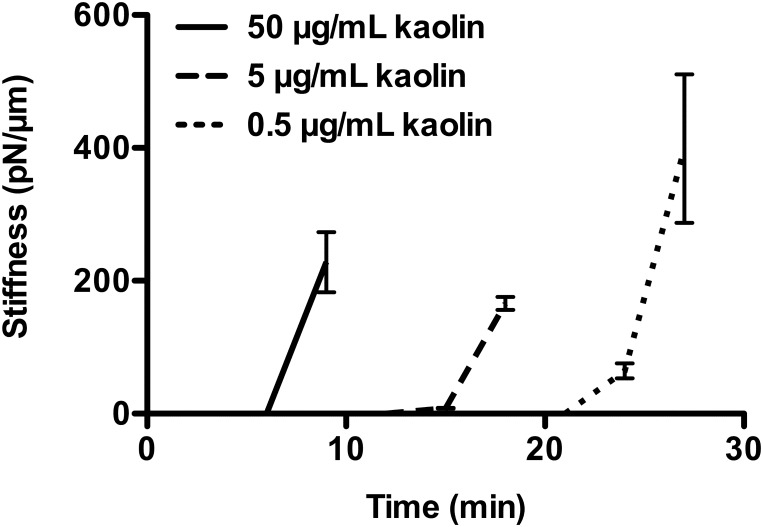
Sensitivity of optical ARF clot stiffness assessment to strength of kaolin clotting stimulus.Clot stiffness of PRP stimulated with 0.5, 5, and 50 μg/mL kaolin was measured by optical ARF. Optical ARF detected kaolin concentration dependent kinetics of clot stiffness. Standard error is shown with at least n = 5 beads per time point.